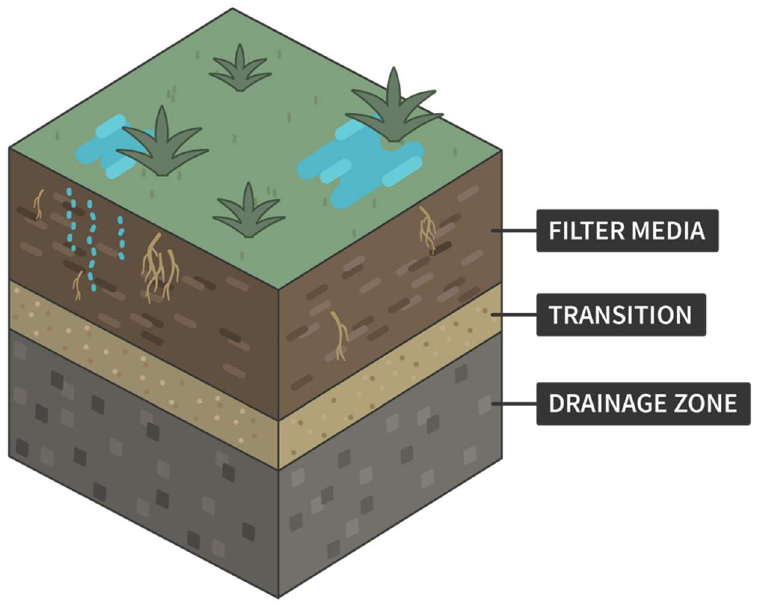
Figure 3. Diagram of a bioretention system with vertical layers.